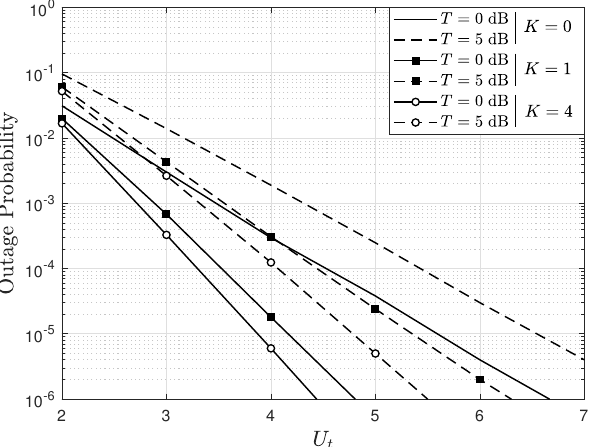
Figure 3. OP as a function of E b / N 0 , parameterized by U t and by e , considering BPSK modulation, A = 4, U = 4, T = 0 dB, and a channel with Rician factor K = 1.